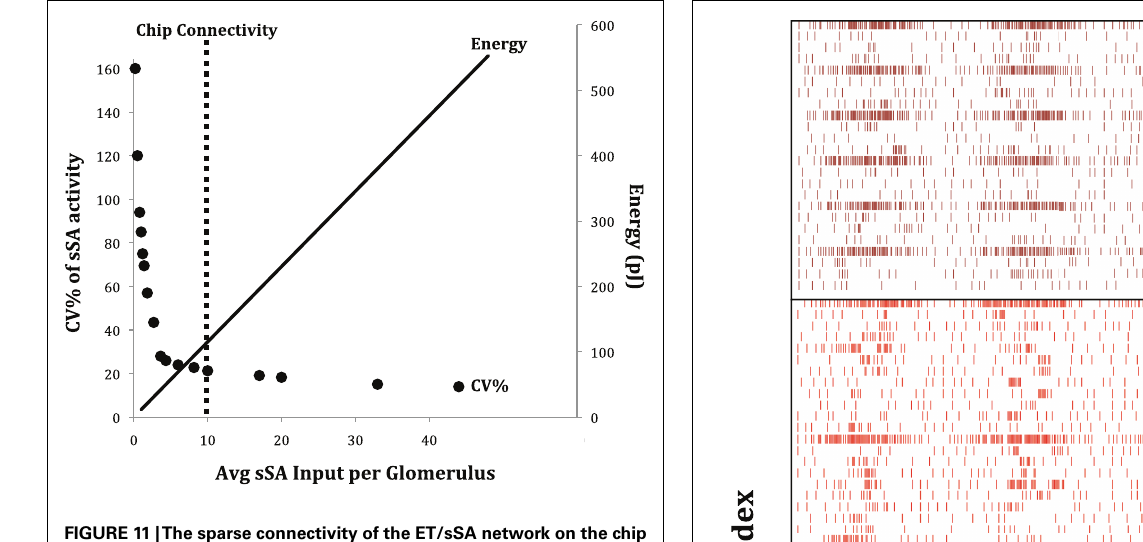
FIGURE 11 |The sparse connectivity of the ET/sSA network on the chip is functionally equivalent to a fully connected network, but carries out global normalization at a reduced energy cost. The abscissa is a measure of the density of sSA connections, bounded by the extremes of a fully isolated network at x = 0 and an all-to-all interconnected network at x = 48.The primary ordinate (left) denotes the coefficient of variation (CV% – the standard deviation as a percentage of the mean) of sSA activity across the sSA population. Low CVs indicate high uniformity in sSA activity across the network.The secondary ordinate (right) denotes the energy consumed in the chip (at its present scale) by updating all synaptic inputs when sSA neurons spike. Denser interconnectivity requires more energy. The dotted vertical line denotes the density of sSA innervation presently implemented in the chip.This reasonably optimized solution corresponds directly to that which appears to be implemented in mouse and rat olfactory bulbs (cf. Figure 5B in Cleland et al., 2007).